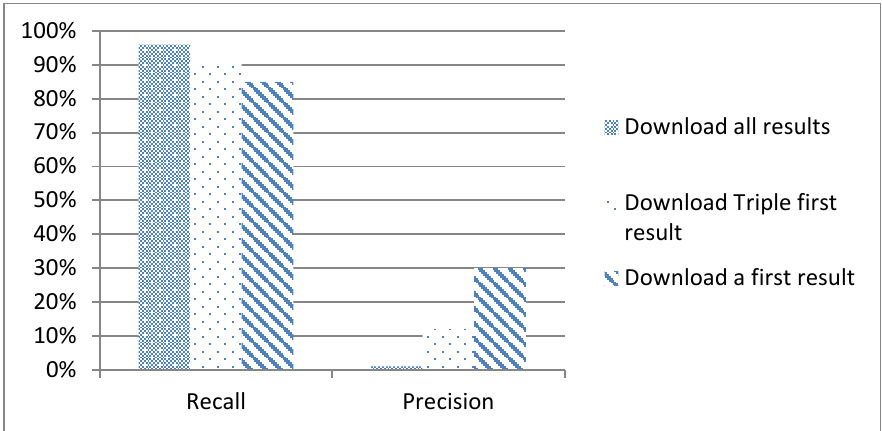
Figure 11: Evaluation of number of downloads for each query.